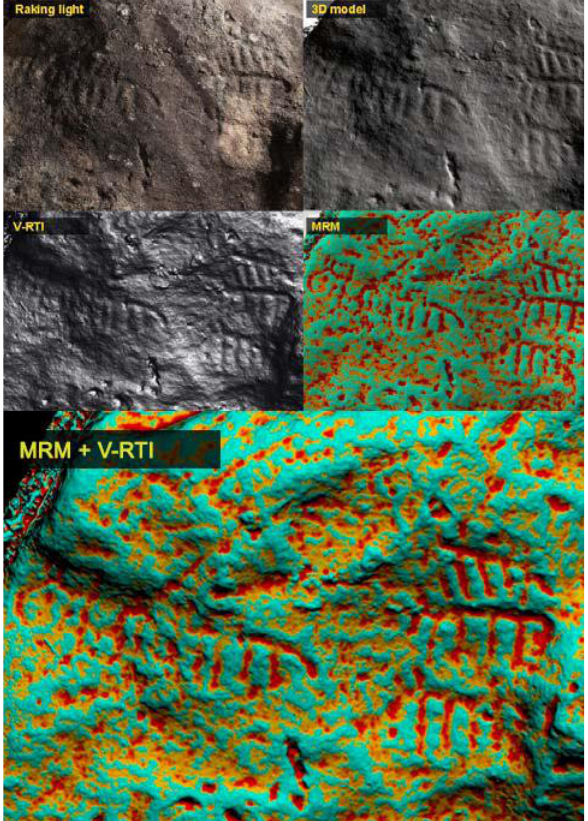
Figure 5: Results of the entire set of techniques discussed in the same engraved panel (from top, left): Raking light photography, 3D scanning, V-PTM, MRM and, at the bottom, MRM in RTI-